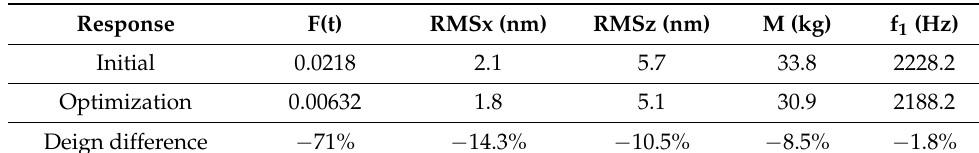
Figure 8. Design optimization results for the primary mirror. Table 4. Results comparison of the initial and optimal design.